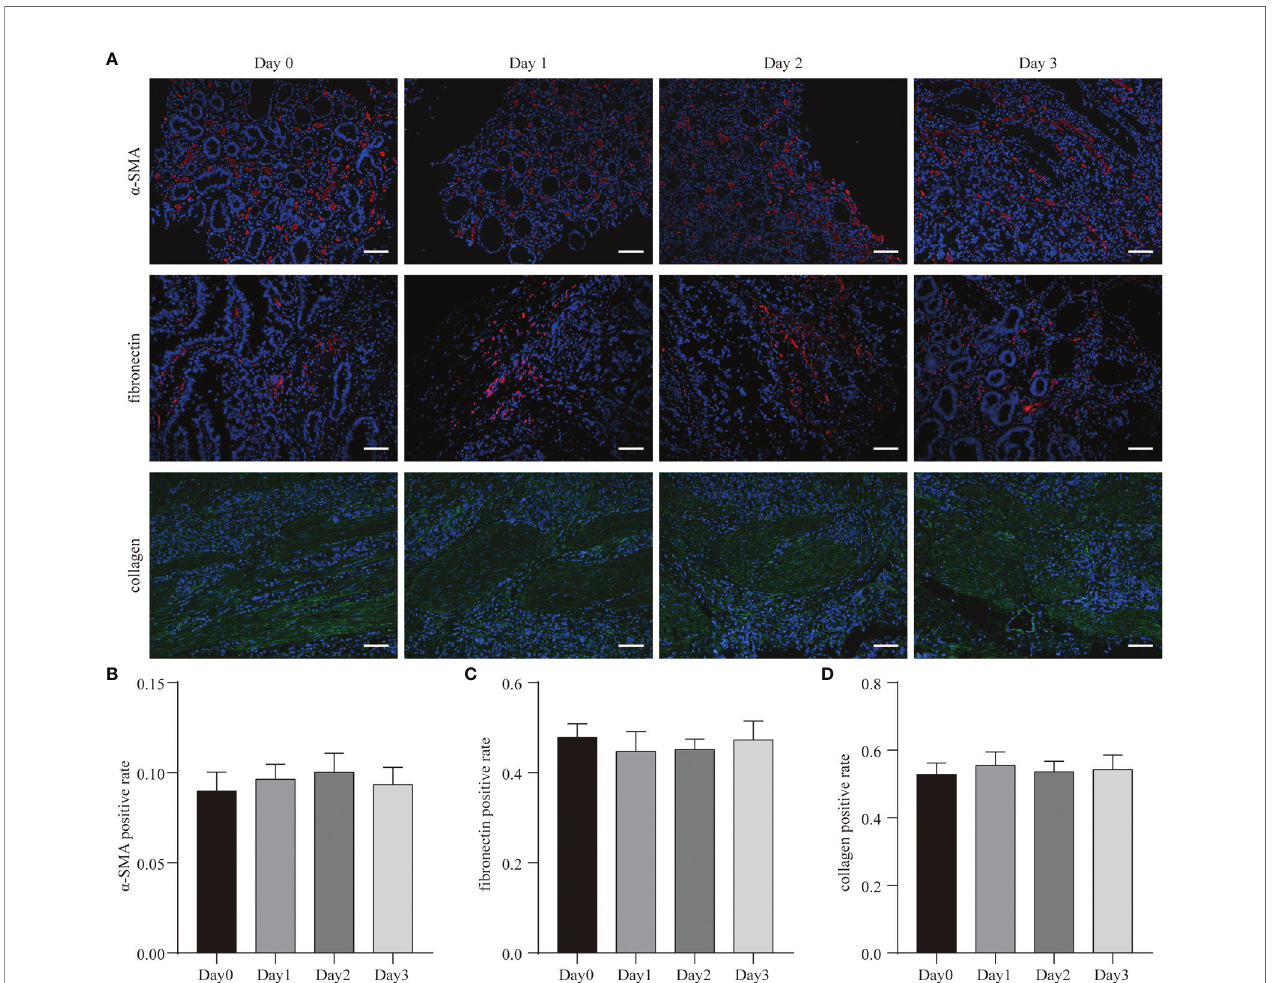
FIGURE 2 | Cell diversity in GC tissue culture. (A) After 3 days culture, the patient-derived GC tissues (Case3) were stained with a -SMA, fi bronectin, collagen, and counterstained with DAPI. Scale bars are all 100 m m. (B – D) Quantitative analysis of a -SMA, fi bronectin, and collagen expression during the 3 days